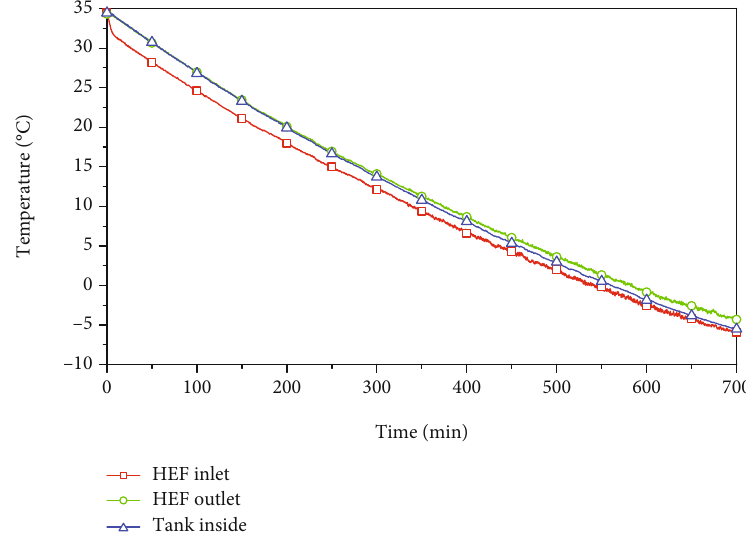
Figure 4: Temperature-time history of brine at inlet, outlet, and inside of the tank for a mass fl ow rate of 400 LPH.